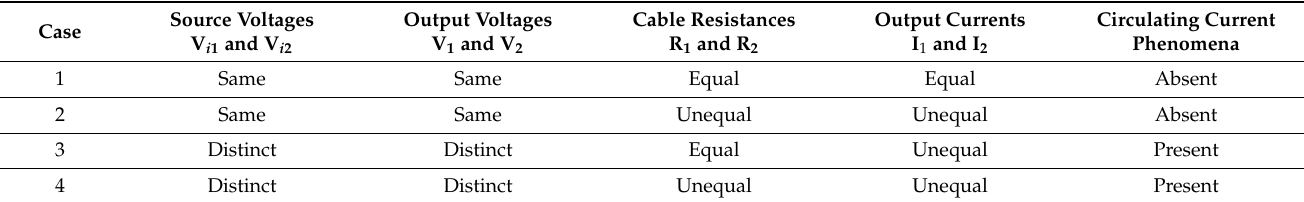
Table 1. Different cases projecting the